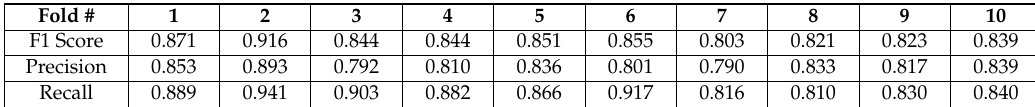
Table 2. The F1 scores of the k-folds for